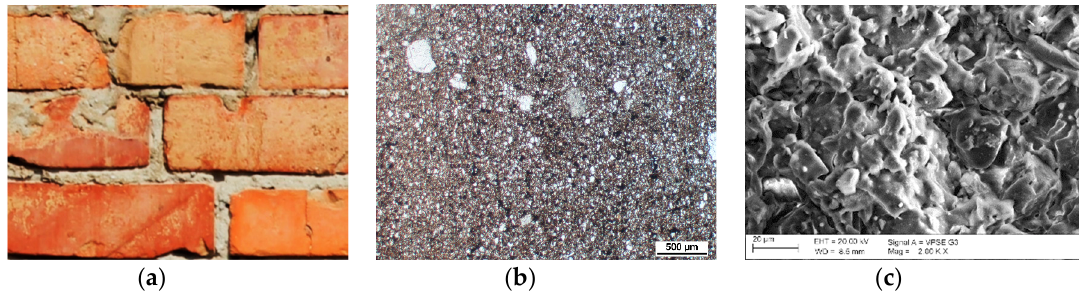
Figure 5. Macroscopic view of damage of the surface of the bricks as a result of cracking ( a ). Optical microscope image. Directional structure of the ceramic mass. Visible are smudges and thin layers containing binding agent with varied fraction of clay substance and iron compounds. Slight directionality of the ceramic mass and a crevice with a pattern matching the component arrangement ( b ). Microstructure of bricks damaged as a result of surface cracking ( c ).